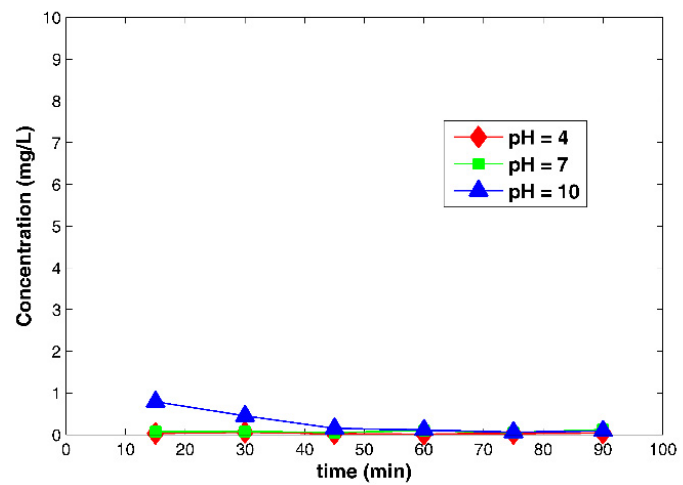
Figure 11. Effect of pH on concentration of Congo Red in permeate during filtration with photocatalytic membrane M1 (C 0 = 10 mg/L, P = 0.5 bar).